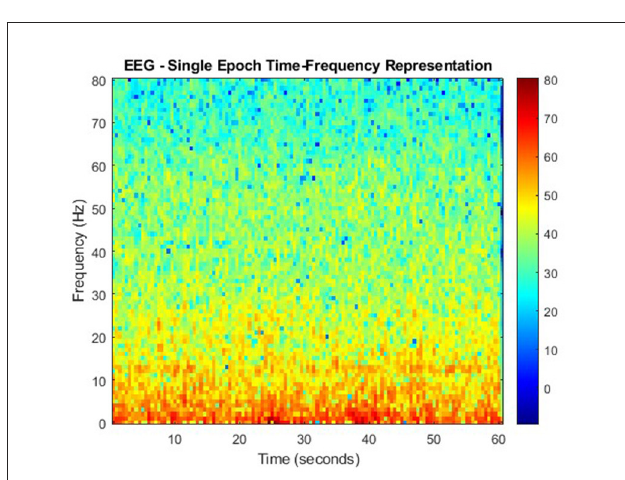
FIGURE6 Time-frequency representation of a signal using the ST.